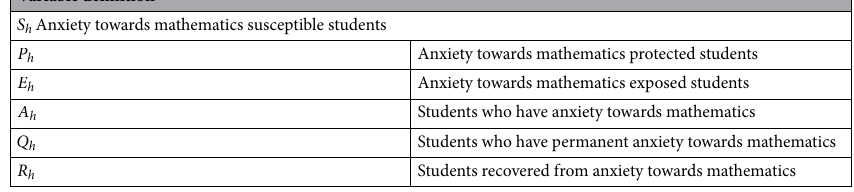
Table 2. Definitions of state variables.